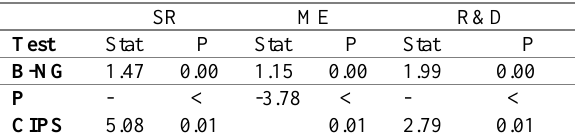
Table 4. Unit root test results of Model